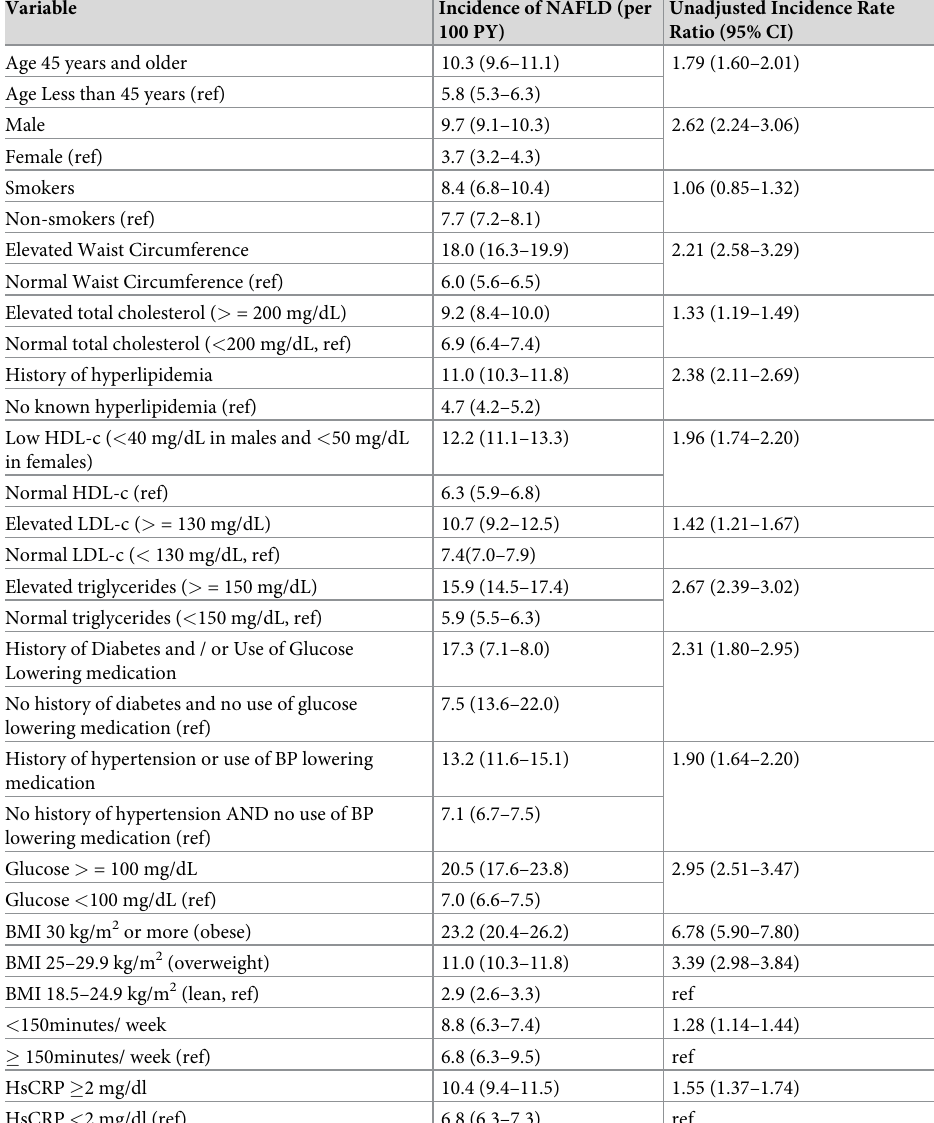
Table 2. Incidence rates and incidence rate ratios of NAFLD for demographic and cardiometabolic risk